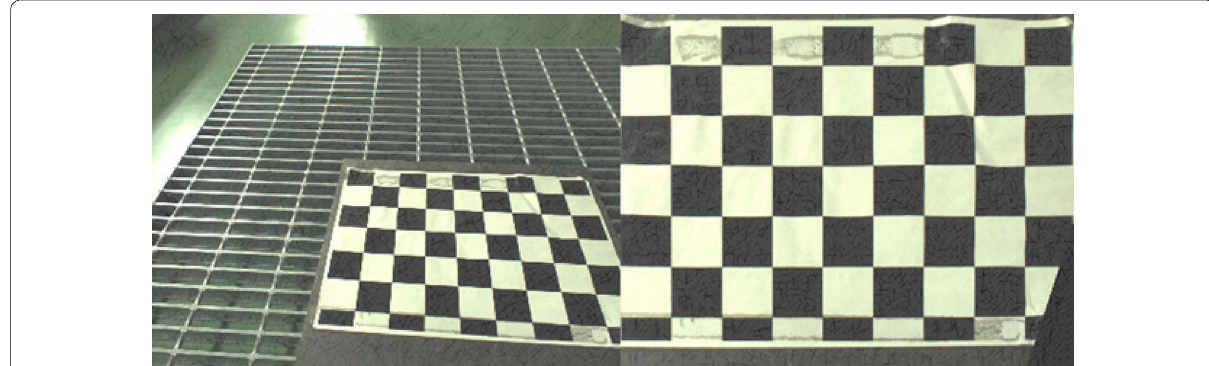
Fig. 6 View change after perspective transformation (left: original image, right: image after